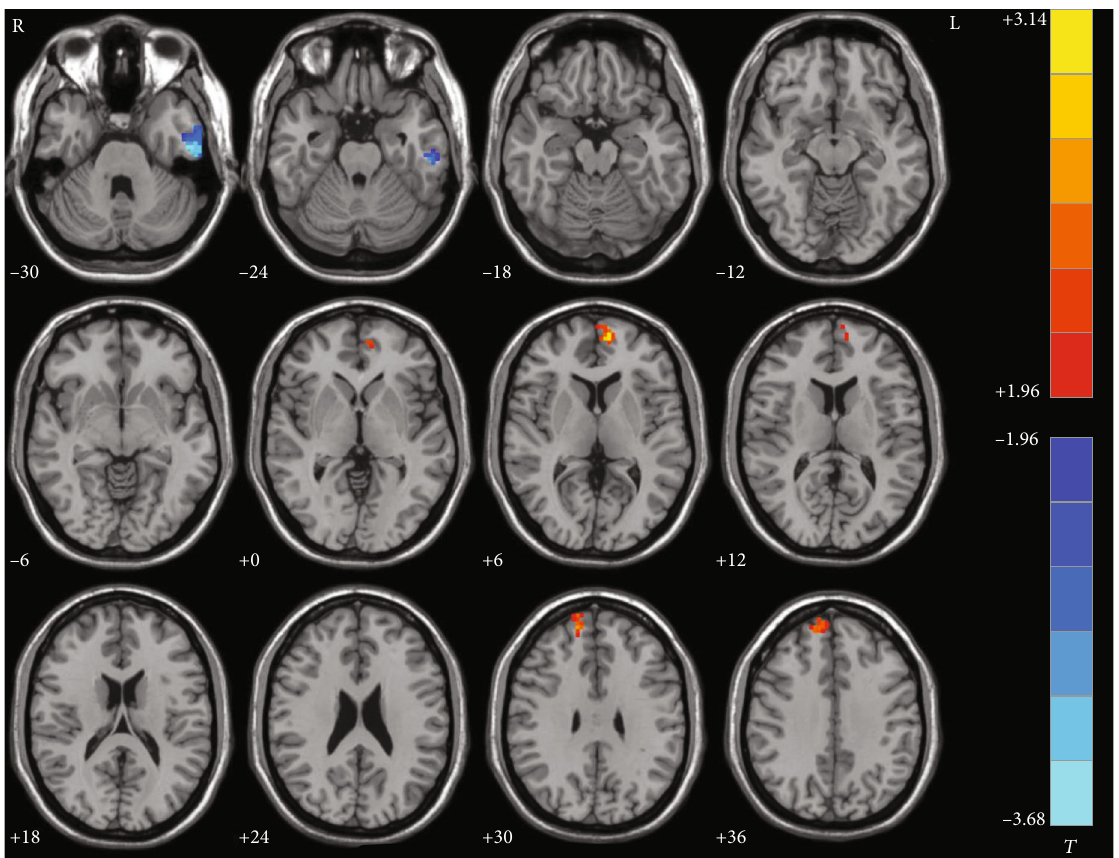
Figure 4: Statistical map depicts higher and lower NH of melancholic patients compared with nonmelancholic patients. The threshold was set at p < 0 : 05 . Blue denotes lower NH and red denotes higher NH. Color bar indicates T values from two-sample t -test. L: left side; R: right side; DMN: default mode network; NH: network homogeneity.